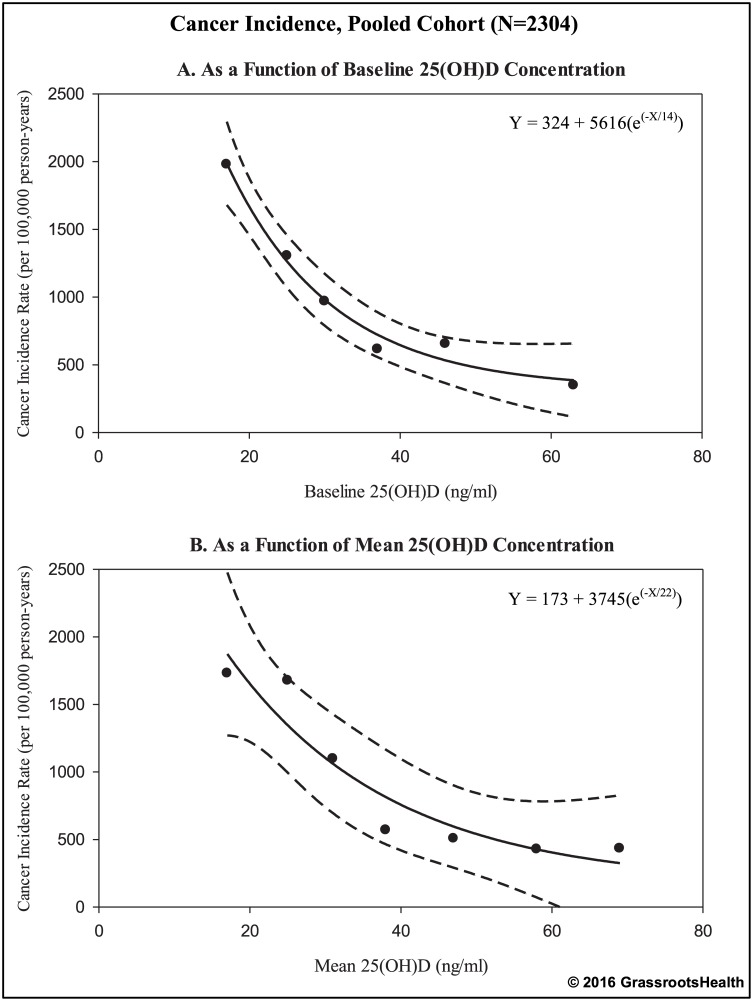
Cancer incidence rates by 25(OH)D concentration with fitted curves, pooled cohort (N = 2304).Black dots represent cancer incidence rates per 100,000 person-years for indicated 25(OH)D groupings (rates are displayed at the median value for each grouping: baseline 25(OH)D groups at 17, 25, 30, 37, 46, and 63 ng/ml; mean 25(OH)D groups at 17, 25, 31, 38, 47, 58, 69 ng/ml), as seen in Fig 1. Solid black lines represent the best fit line to the exponential equation: Y = A + B(e(-X/C)), where Y = cancer incidence rate, X = serum 25(OH)D (dashed lines represent the 95% confidence intervals).